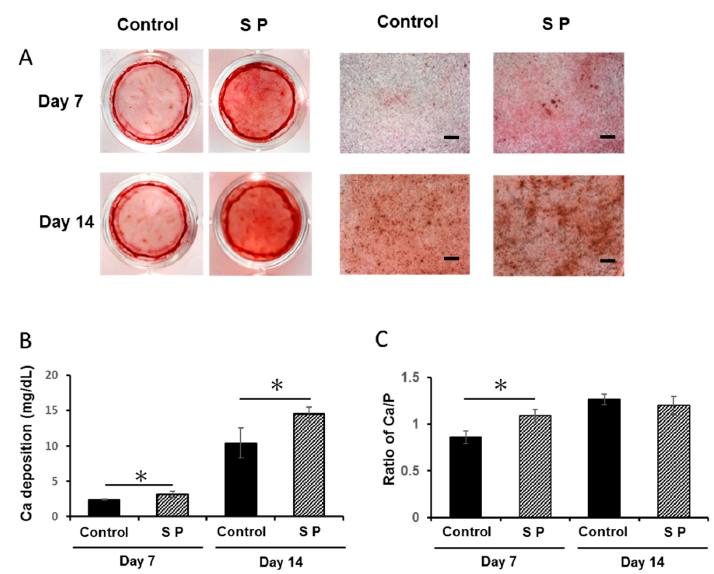
Figure 4. SP enhanced the mineralized nodule formation under growth conditions, as measured by ( A ) alizarin red staining, ( B ) calcium deposition, and ( C ) phosphate deposition (ratio of Ca / P) in the extracellular matrix. Scale bar in ( A ), 100 µm.